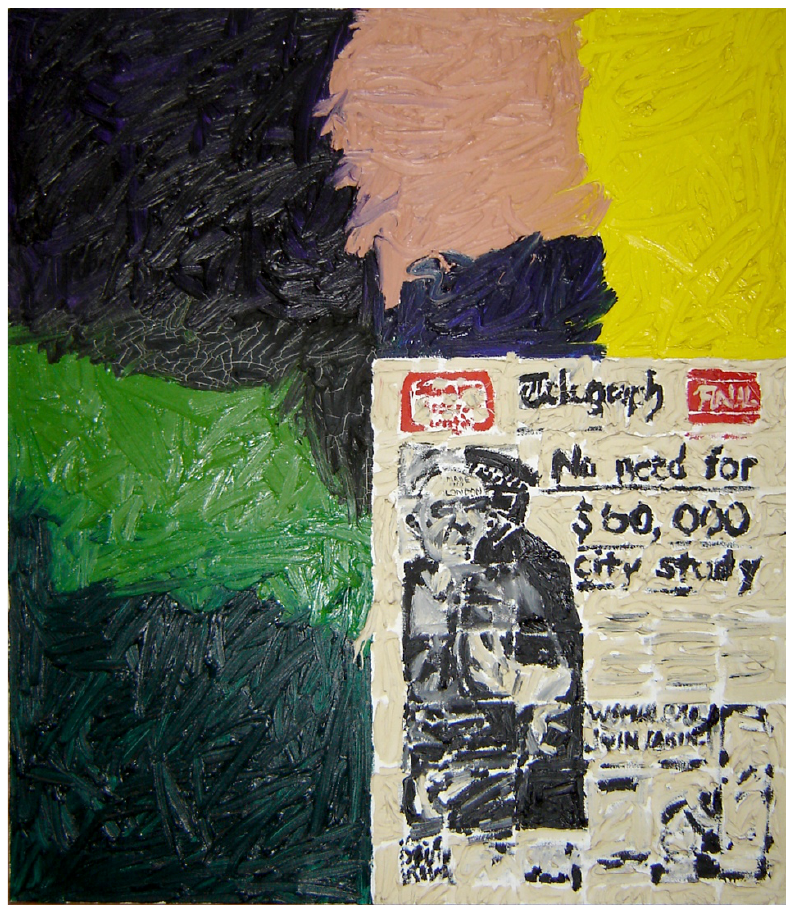
Jenny Watson, A Painted Page: The Telegraph , [1980], oil on cotton duck, 66 x 52 cm. Private collection, Brisbane, courtesy Josh Milani Gallery, Brisbane. Copyright Jenny